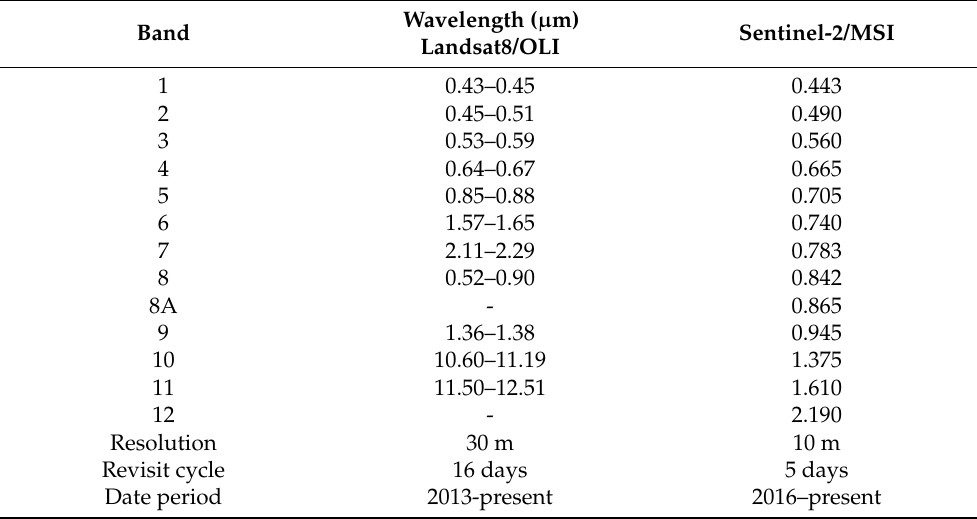
Table 1. Satellite image